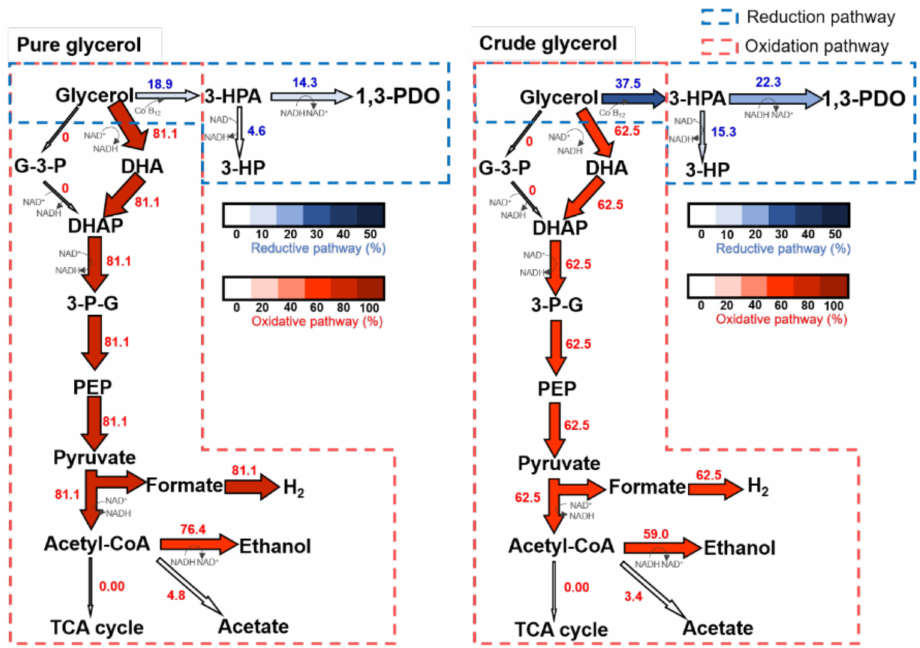
Figure 4. The metabolic flux analysis of crude and pure glycerol was calculated using the meta flux net